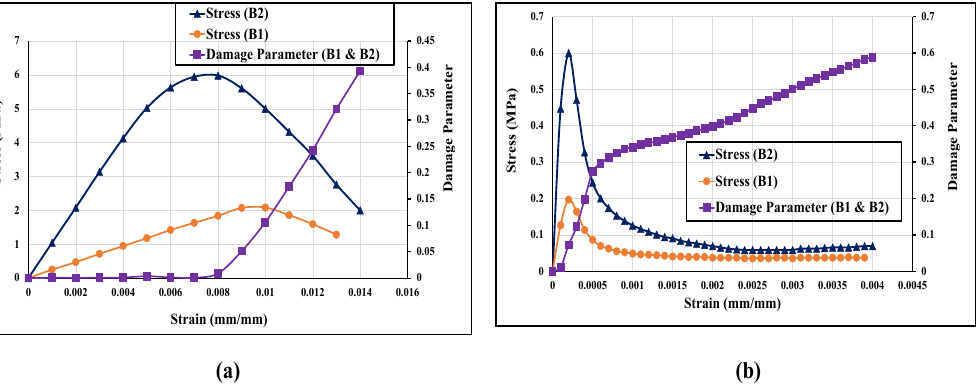
Figure 4. Input stress-strain and damage properties of brick wallettes; ( a ) compression and ( b ) tension. Table 3. CDP model parameters.